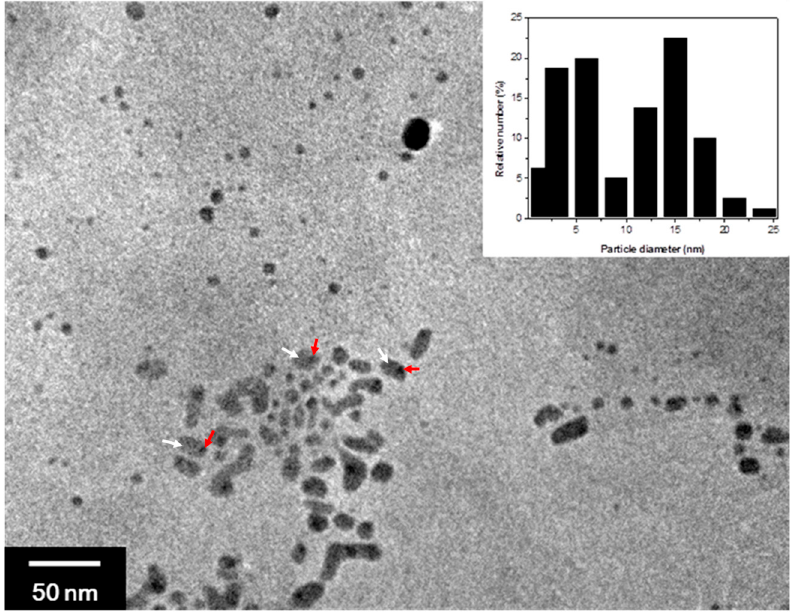
Figure 6. TEM image of AgNP/ZnONP/NSP with a weight ratio of 1/10/99. The size distribution is inserted. AgNP and ZnONP are indicated by red arrows and white arrows, respectively.